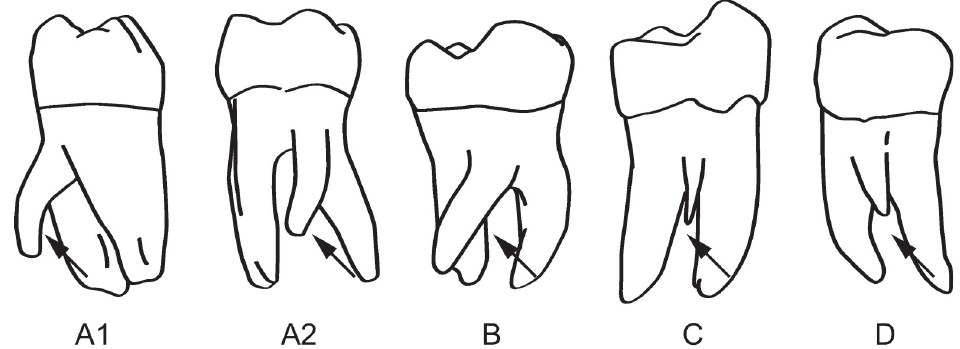
Fig 1. Examples of accessory roots. Mandibular 1 st molars with A1 and A2: radix entomolaris (left = distolingual surface, right = lingual surface), B: M 3 with radix entomolaris (lingual view), C: M 1 with furcation root (buccal view), D: M 1 with fused radix paramolaris (buccal view). Modified from Calbersen et al. [36].